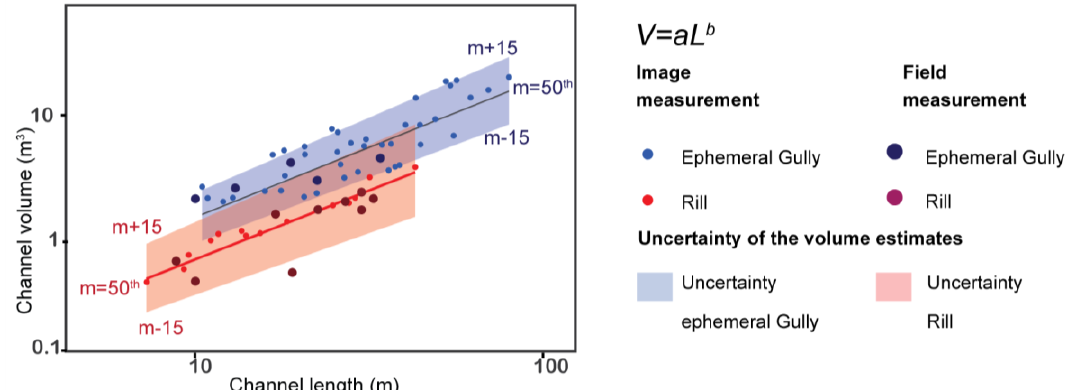
Figure 12. Power law relationship ( 𝑉 = 𝑎𝐿 𝑏 ) in a bi-logarithmic diagram for the rills and ephemeral gullies and the associated uncertainties. The small blue and red dots are the ephemeral gully volumes and rill volumes, respectively, which were measured using the stereo satellite images, and the large blue and red dots are the volumes of the rills and gullies, respectively, which were measured in the field. The uncertainties that are associated with the power law fits for the rills (red shaded area) and ephemeral gullies (blue shaded area) are defined based on the 35th percentile (m − 15) and the 65th percentile (m + 15), respectively, of the power law parameters a and b